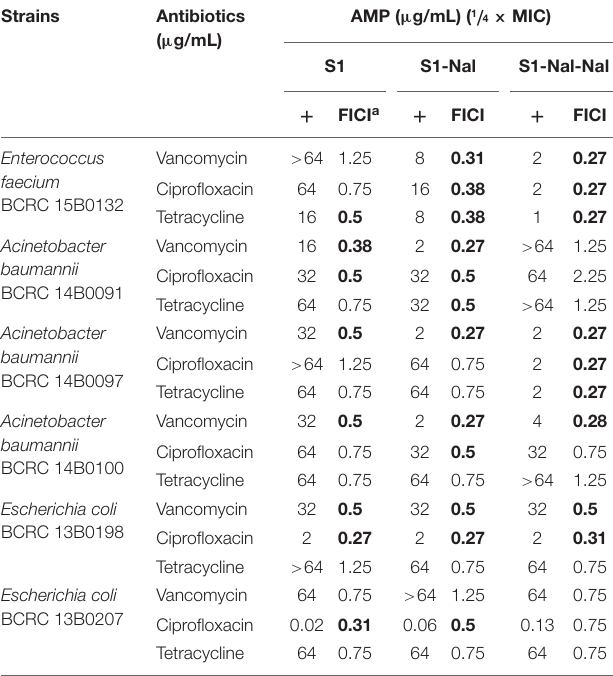
TABLE 3 | Synergistic effects of S1, S1-Nal, and S1-Nal-Nal in combination with antibiotics against bacterial strains